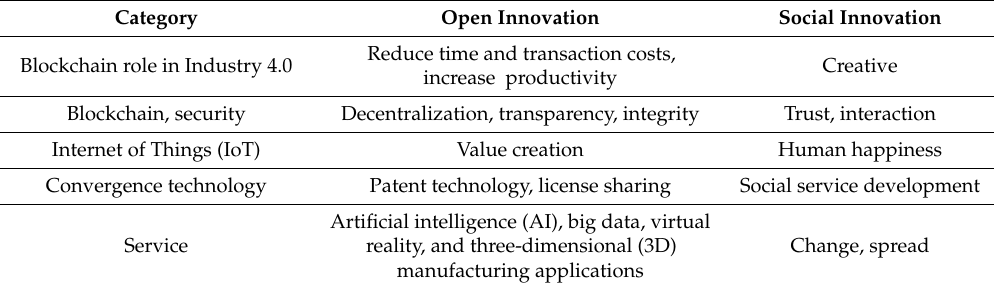
Table 1. Blockchain-technology-based open innovation and social innovation application